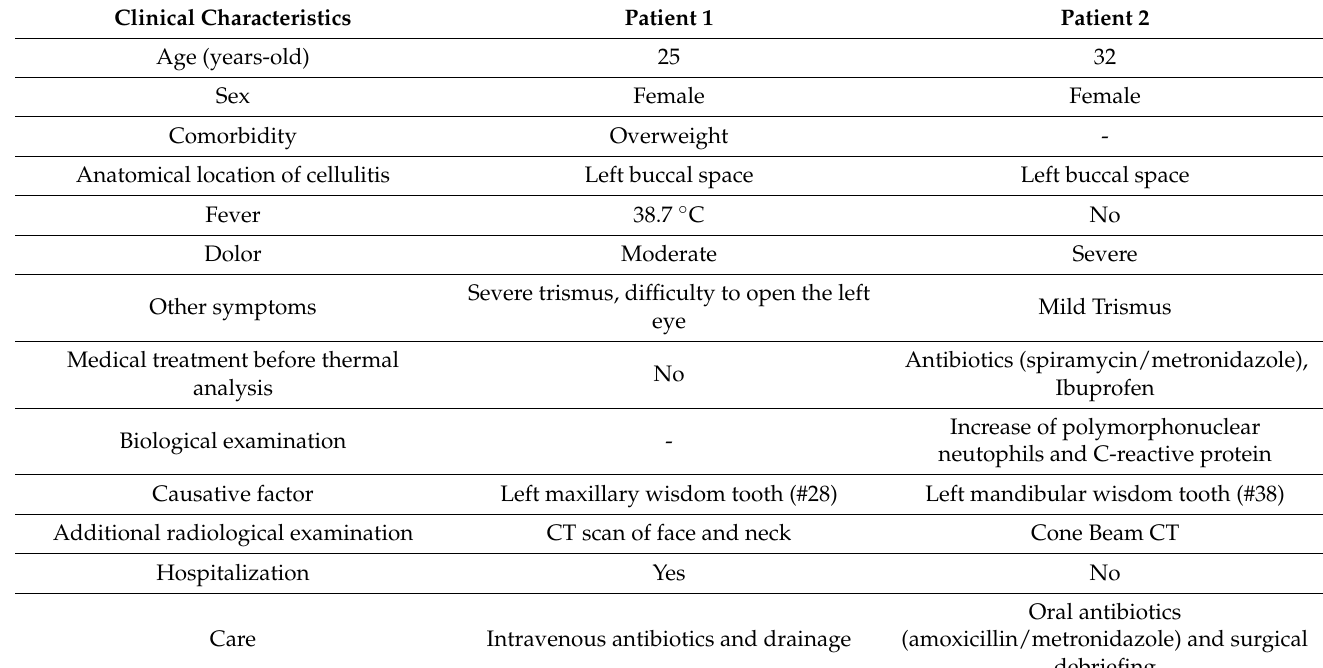
Table 1. Clinical information of